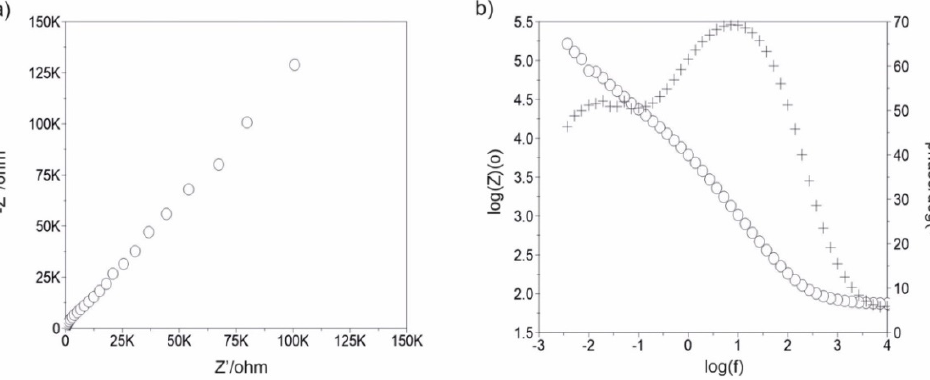
Figure 7. Impedance spectra determined for the initial state of the sandblasted samples: ( a ) Nyquist diagram, ( b ) Bode diagram.